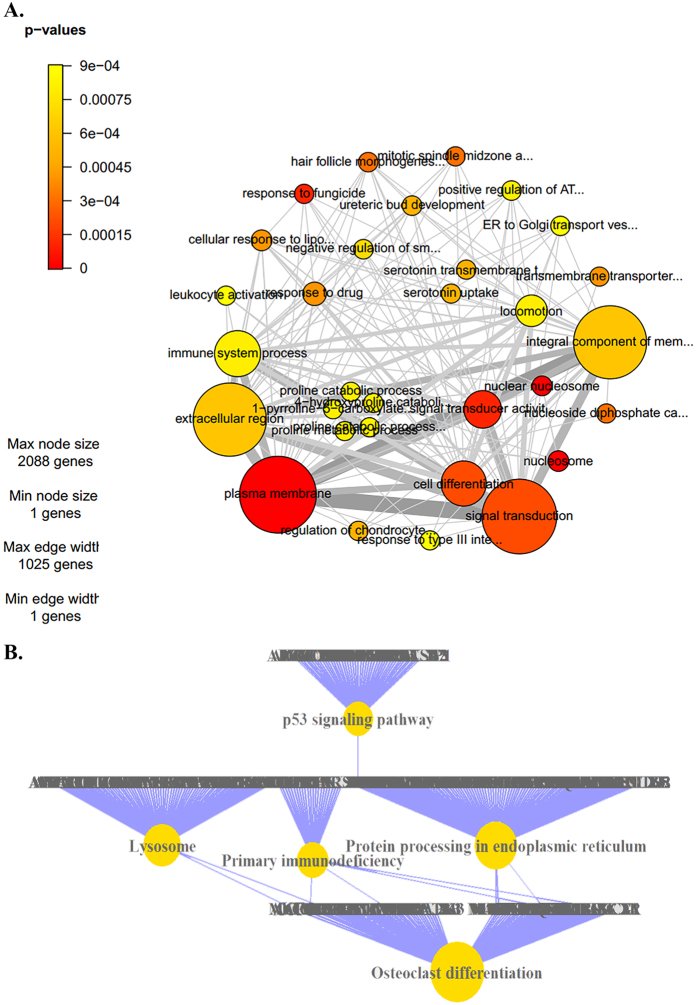
Pathway analysis of the genes.Gene sets that are significant (p < 0.001) in the non-directional class from the GO enrichment analysis. Only gene sets with 5 or more genes were retained. The network plot shows the relation between gene sets by connecting those that share member genes. The color of nodes indicates P values. The thickness of the edges corresponds to the number of shared genes. The size of the nodes corresponds to the size of the gene sets.